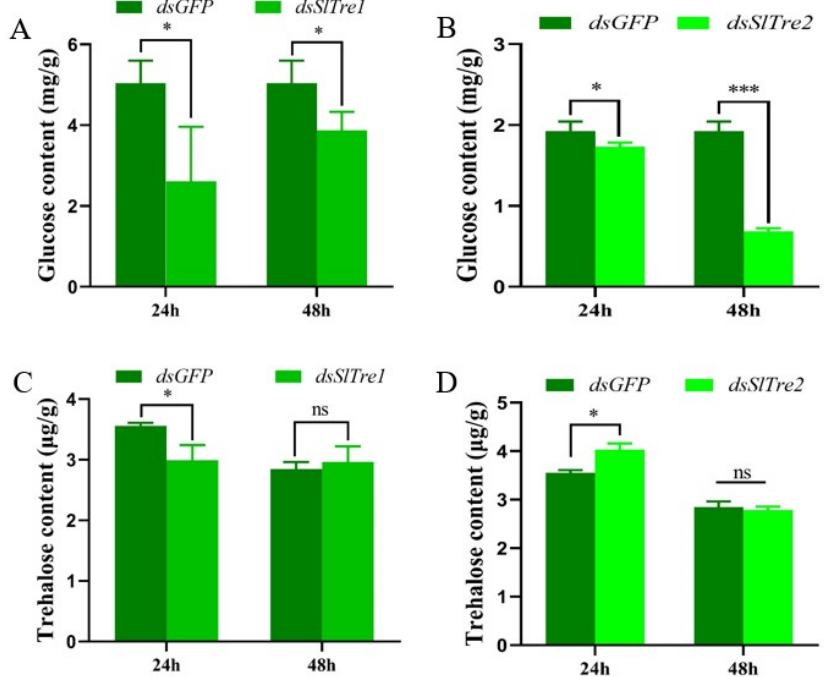
Figure 5. Glucose ( A , B ) and trehalose content ( C , D ) in parasitized S. litura larvae after RNAi at 24 and 48 h. Significant differences in the glucose and trehalose content were compared using ANOVA. Significant differences are indicated by asterisks (* p < 0.01; *** p < 0.001; ns: no significant differences, Table S4).